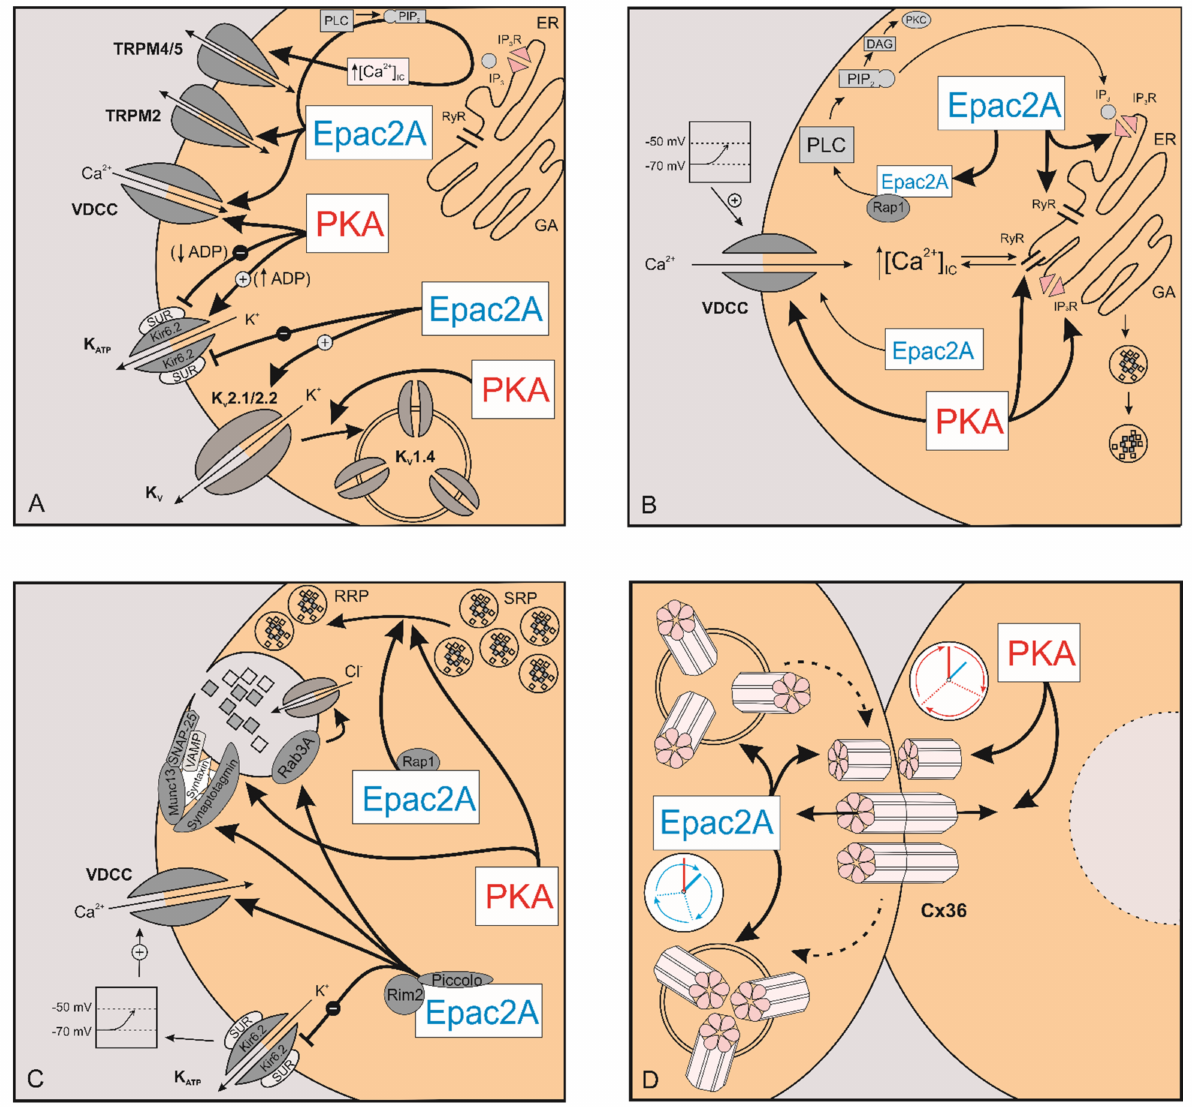
Figure 2. The role of PKA and Epac2A in stimulus–secretion and intercellular coupling. The effect of PKA and Epac2A